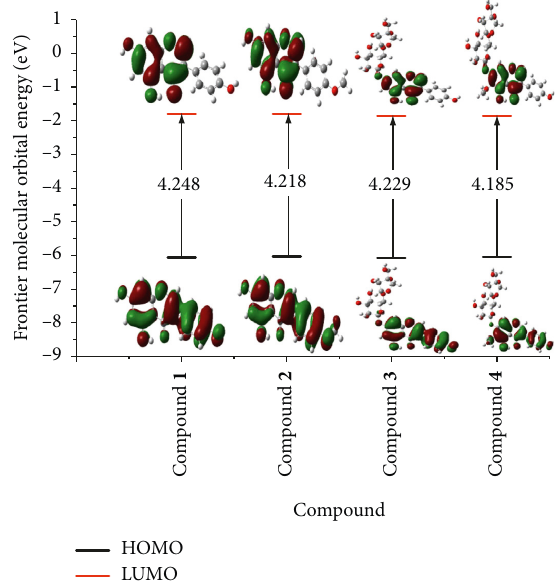
Figure 5: Neutral HOMO and LUMO images and E tures 1–4 in MeOH